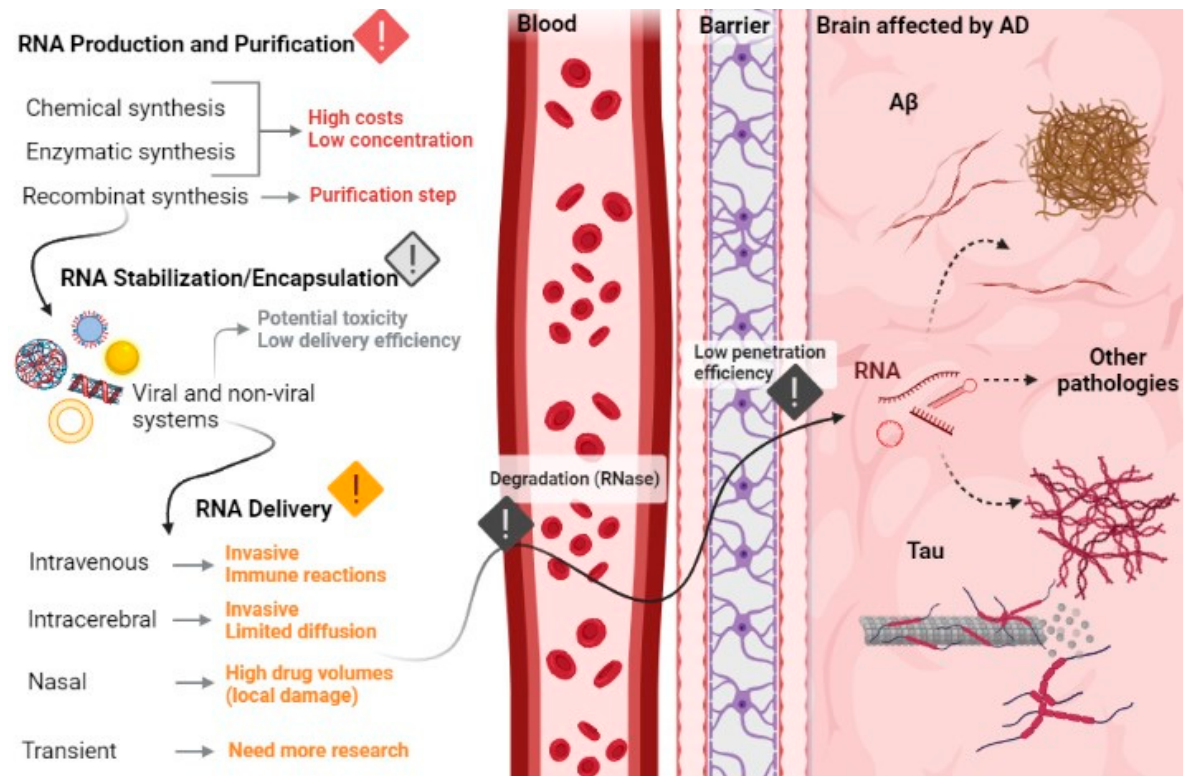
Figure 8. Overview of the main challenges in the development of RNA-based therapeutics, from production until brain cells delivery.